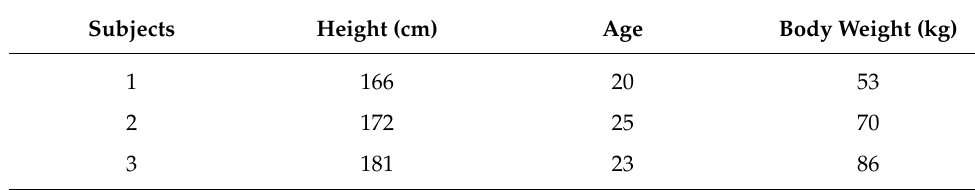
Table 11. Comparison of maximum torque during hip